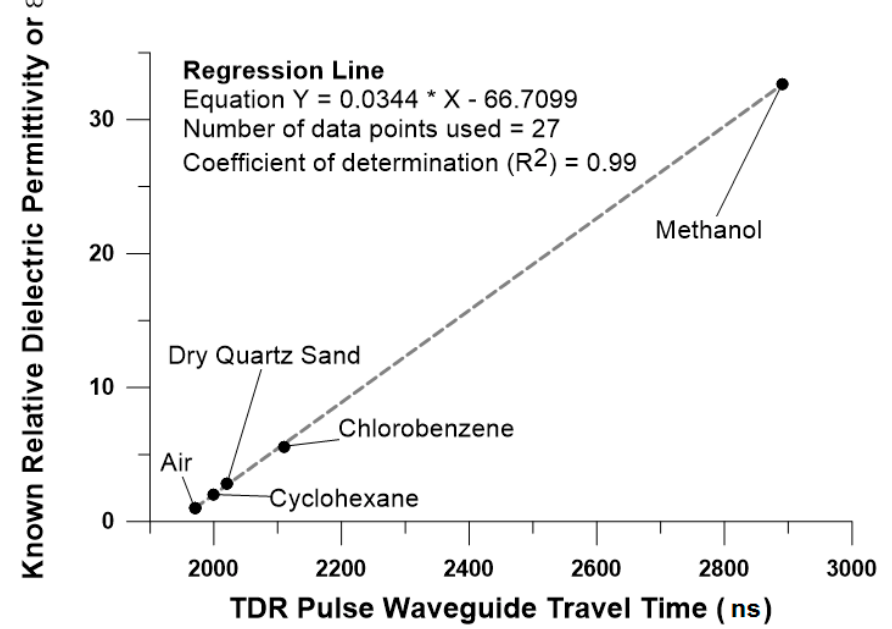
Figure 4. Calibration curve for conversion of TDR pulse transit times to dielectric permittivity.